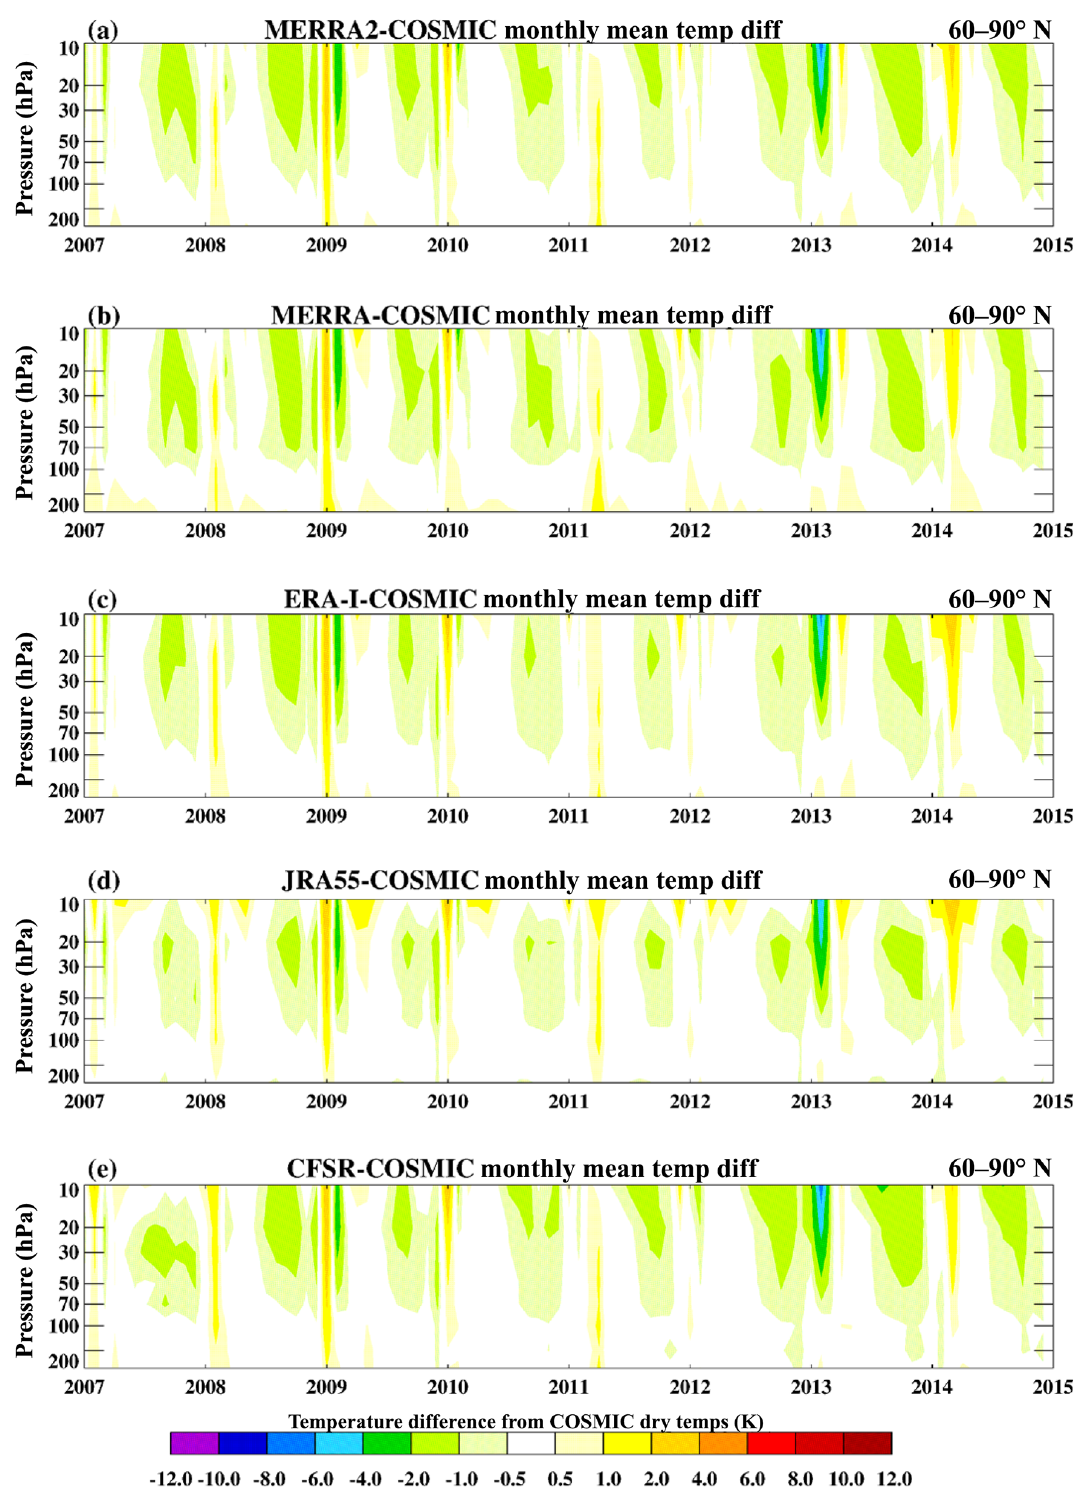
Figure 16. Same as Fig. 15 except for the Northern Hemisphere high-latitude zone (60–90 ◦ N).